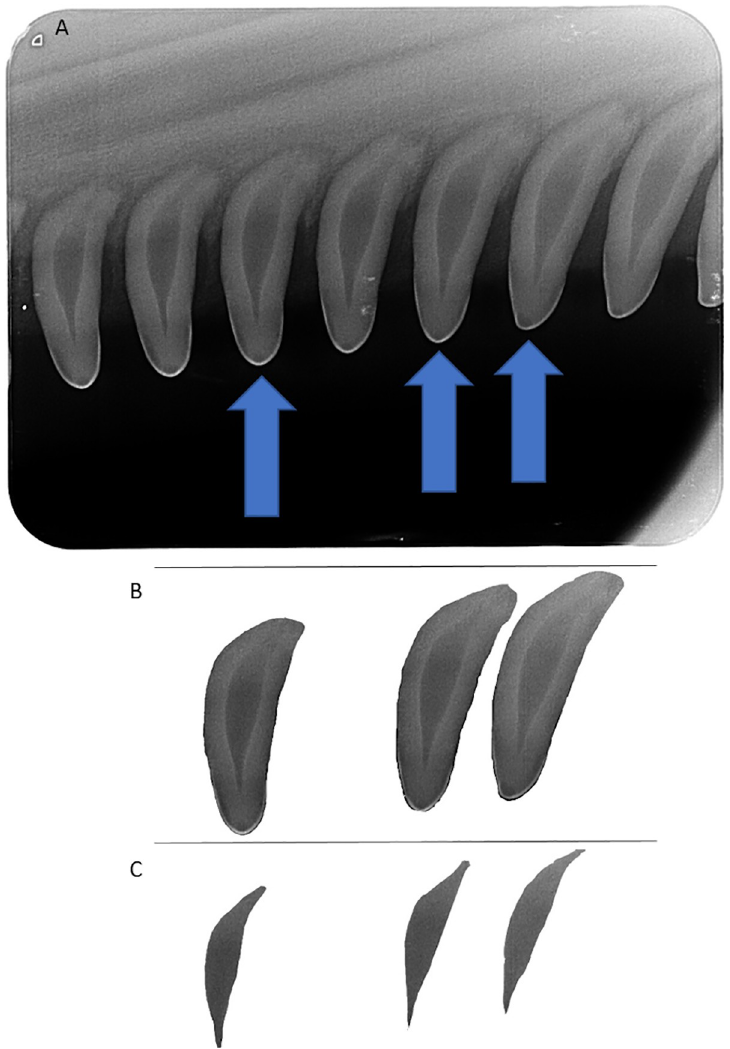
Fig 3. Periapical dental X-ray radiograph from a wild bottlenose dolphin. Three maxillary teeth per individual (A) were selected to calculate the tooth area (B) and pulp area (C) using similar methods to those described by White et al. [55]. Briefly, the lasso and histogram tools in Adobe Photoshop were used to count the number of pixels in each area, then the pulp:tooth area ratio was used to estimate the age of the